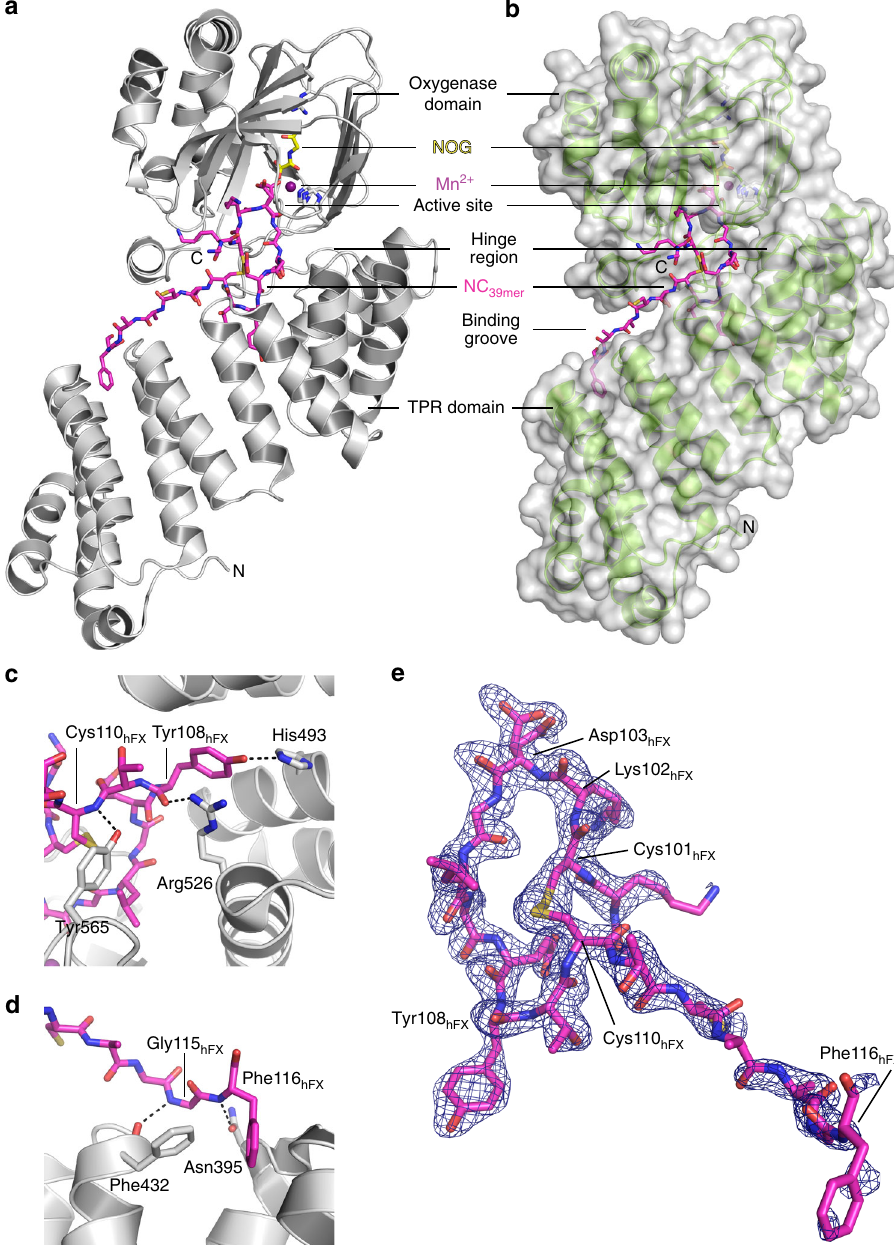
Fig. 3 Structure of AspH-TPR-Ox:hFX features a non-canonical EGFD disul fi de connectivity. Color code: magenta: carbon-backbone of NC 39mer peptide; yellow: carbon-backbone of N -oxalylglycine (NOG); violet: Mn; red: oxygen; blue: nitrogen; pale yellow: sulfur. a Overview of the AspH-TPR-Ox:hFX structure; His 6 -AspH 315 – 758 in grey. b Surface representation (grey) of the AspH-TPR-Ox:hFX structure showing the substrate-binding groove, His 6 - AspH 315 – 758 in green. c Interactions of the TPR domain residues His493 and Arg526 as well as the hinge region residue Tyr565 with the NC 39mer peptide. d Additional interactions of the TPR domain with the NC 39mer peptide: Asn395 forms a hydrogen bond with Phe116 hFX (3.0 Å) and Phe432 forms a hydrogen bond with Gly115 hFX (3.2 Å). e OMIT electron density map (mFo – DFc) contoured to 3 σ around the hFX derived NC 39mer peptide supports the presence of a non-canonical disul fi de bridge between Cys101 hFX and Cys110 hFX as a substrate requirement for AspH (canonical EGFD disul fi de isomer: Cys1 – 3, 2 – 4, 5 – 6; non-canonical EGFD disul fi de isomer: Cys1 – 2, 3 – 4, 5 – 6; see Fig. 5a). Note that electron density for two alternative conformation of the Asp103 hFX side chain is